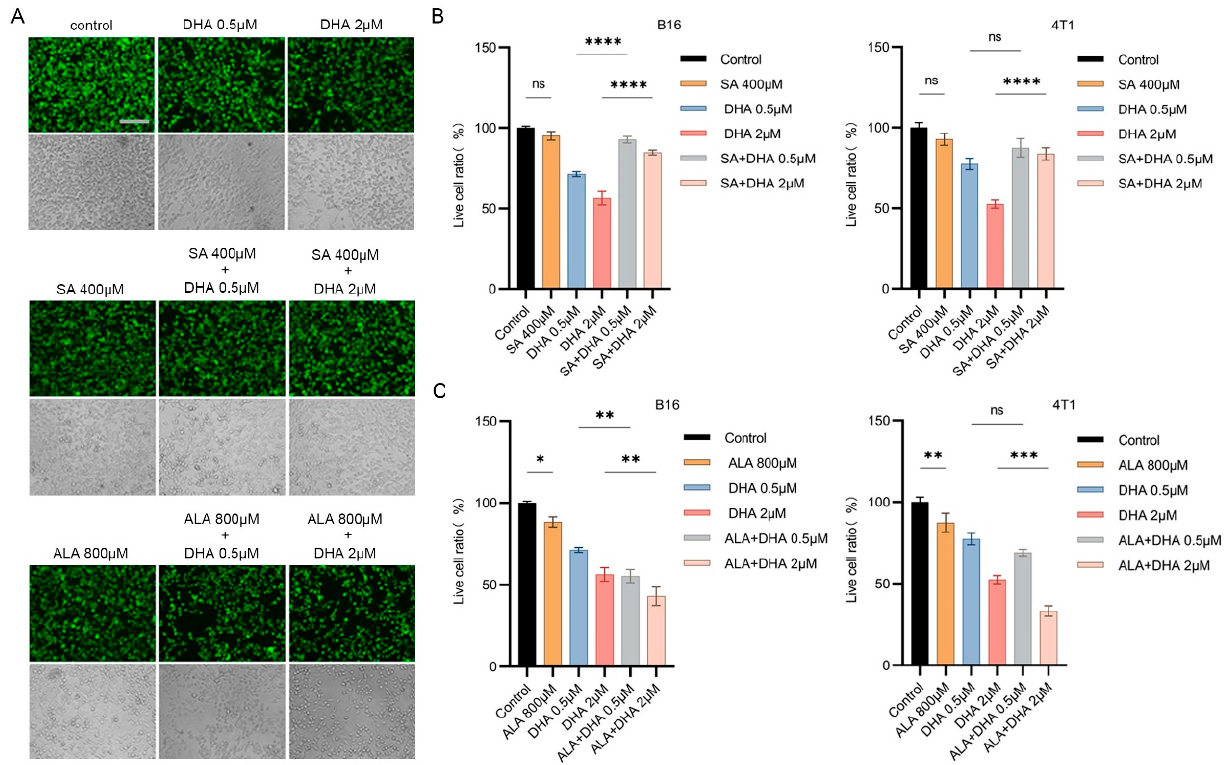
Figure 2. The antitumor activity of DHA depends on intracellular heme synthesis. ( A ) Representa- tive fluorescence microscope images of B16 cells treated with DHA, SA, ALA alone, or combinations of DHA with SA or ALA (bar = 125 μ m). SA (succinylacetone) is a heme inhibitor, whereas ALA is precursor of heme during its synthesis. Cells were stained with Calcein-AM. Photos were taken under green fluorescence and bright field conditions, respectively. ( B ) Cytotoxicity analysis of DHA, SA, ALA alone or DHA+SA and DHA+ALA in B16 cells. ( C ) Cytotoxicity analysis of SA, ALA, and DHA in 4T1 cells. * p < 0.05, ** p < 0.01, *** p < 0.001, **** p < 0.0001.